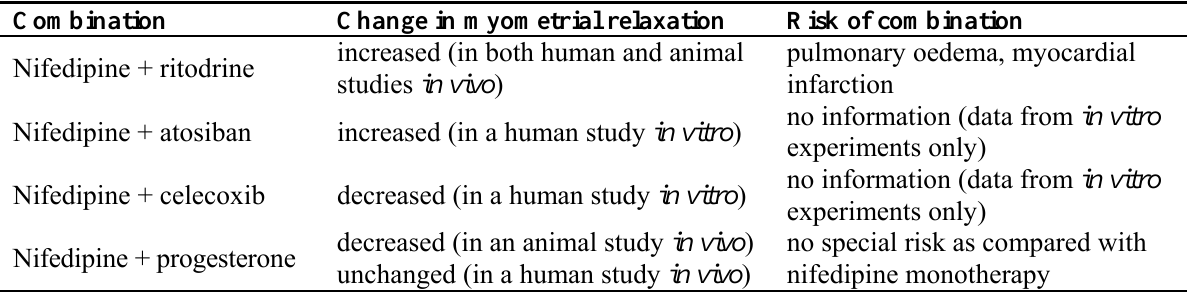
Table 3. Myometrial effects of different combinations of